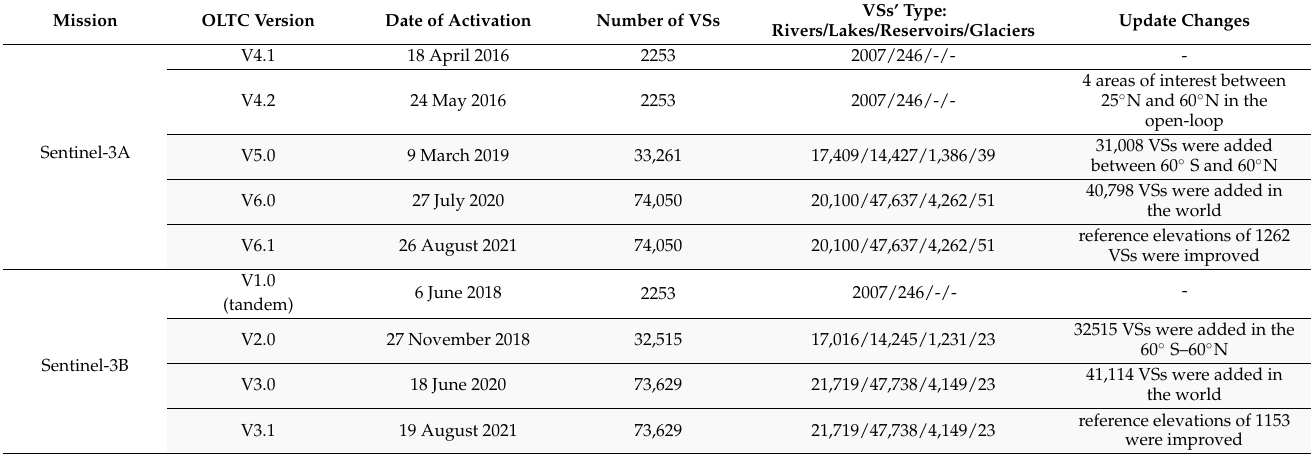
Table A1. Description of successive open-loop tracking command (OLTC) versions on Sentinel-3A and Sentinel-3B.